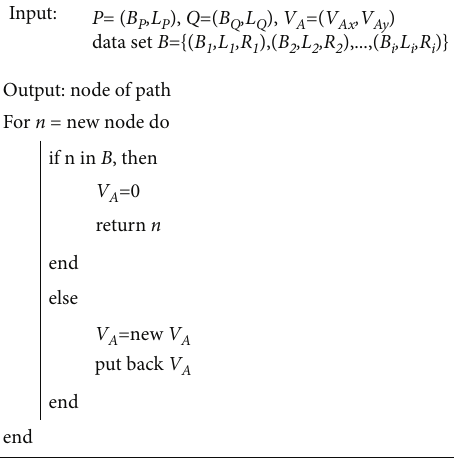
Figure 7: Program pseudocode.